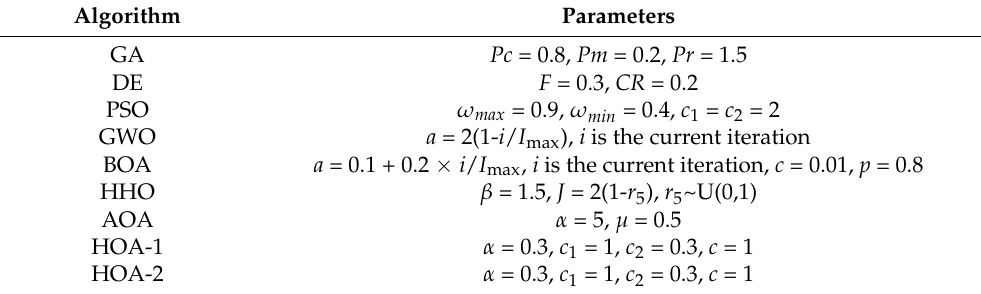
Table 1. Parameters setting.